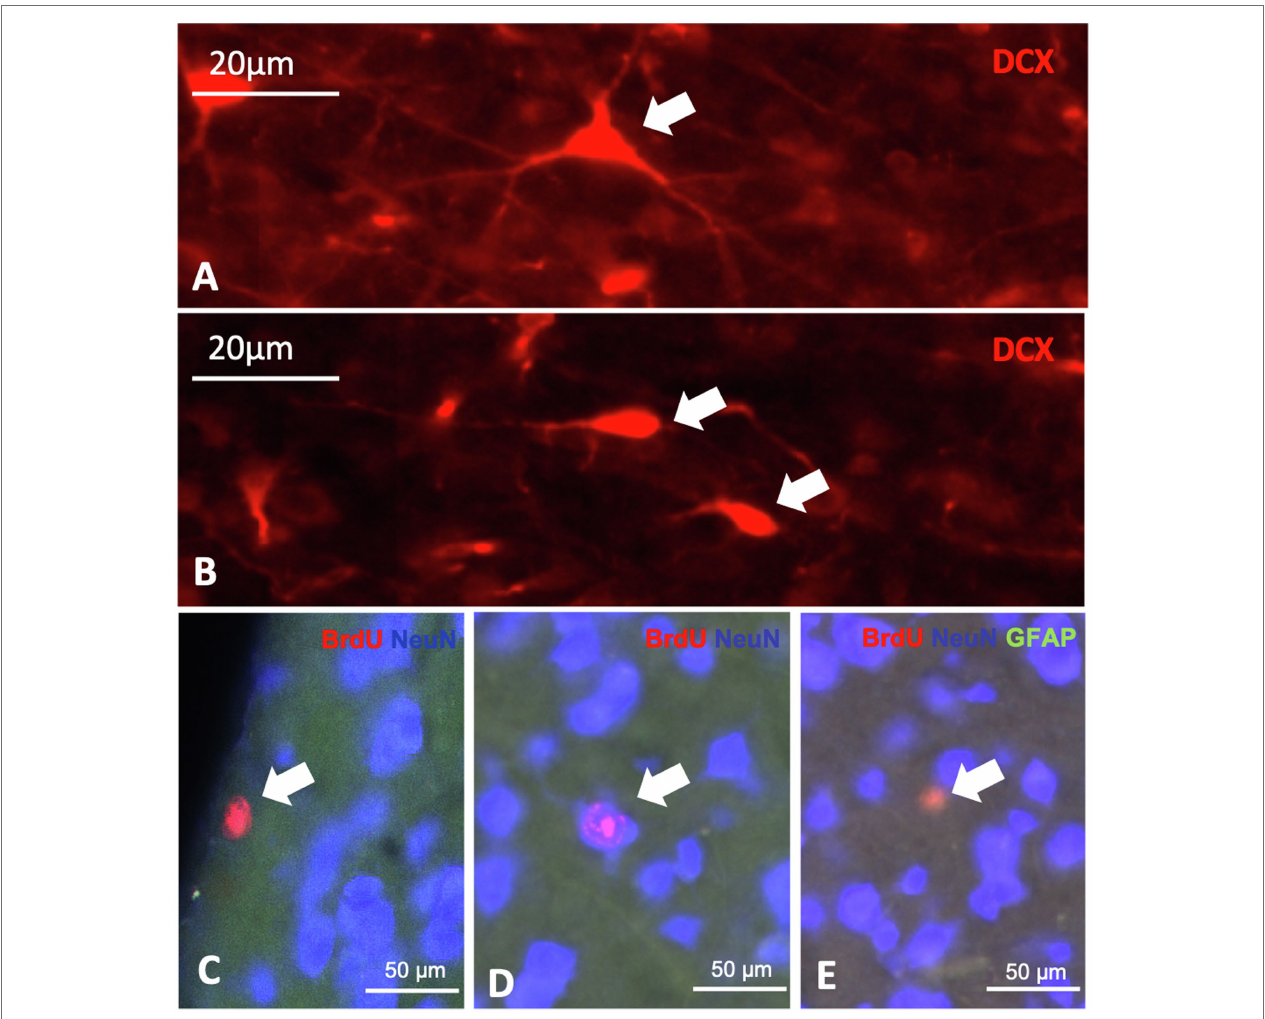
FIGURE 8 | Expression of neurogenic markers in the telencephalon of the pigeon. A + B : different DCX positive cells, characterized by shape, the triangular cell (A) and the ovoid cell (B) . c-e : BrdU, NeuN and GFAP triple labelling showing BrdU positive cells (C) , double labelled BrdU/NeuN cells (D) and double labelled BrdU/GFAP cells (E)